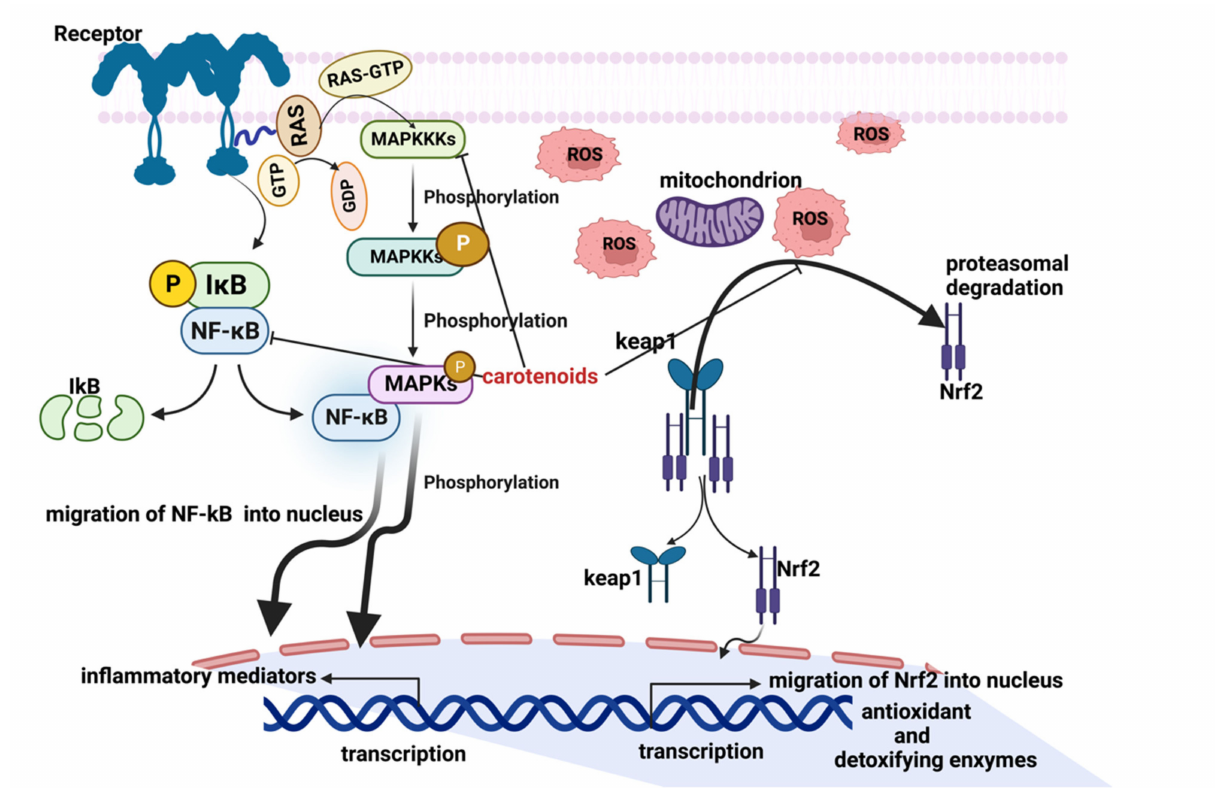
Figure 4. Mechanisms of the anti-diabetic effects of carotenoids. During oxidative stress, I κ B is phosphorylated by IKK, resulting in the release of NF- κ B. NF- κ B is translocated to the nucleus, and the transcription of inflammatory cytokines can commence. Carotenoids inactivate the NF- κ B pathway. Carotenoids inhibit the degradation of Nrf2 and interact with Keap1. Nrf2 migrates to the nucleus, and the transcription of antioxidant and detoxifying enzymes can start. Carotenoids inhibit MAPK signaling from reaching the nucleus